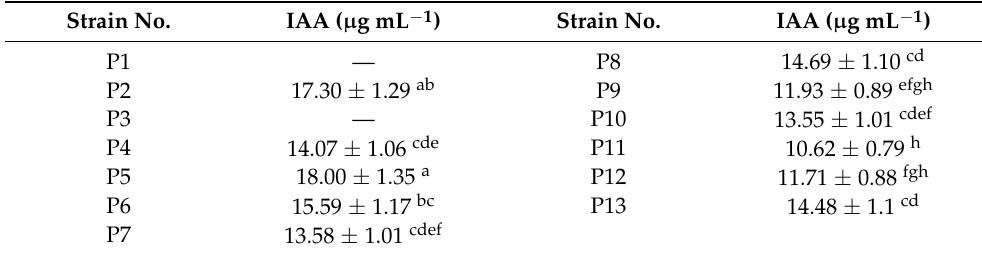
Table 5. Indole-3-acetic acid IAA) productions of phosphorus-dissolving bacteria. Strain No. IAA ( µ g mL − 1 )